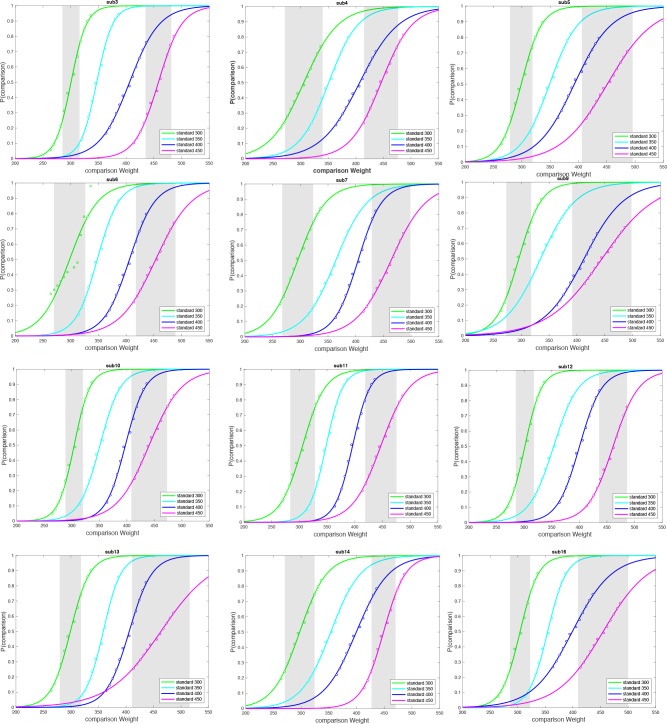
Individual Psychometric functions for the TD group.